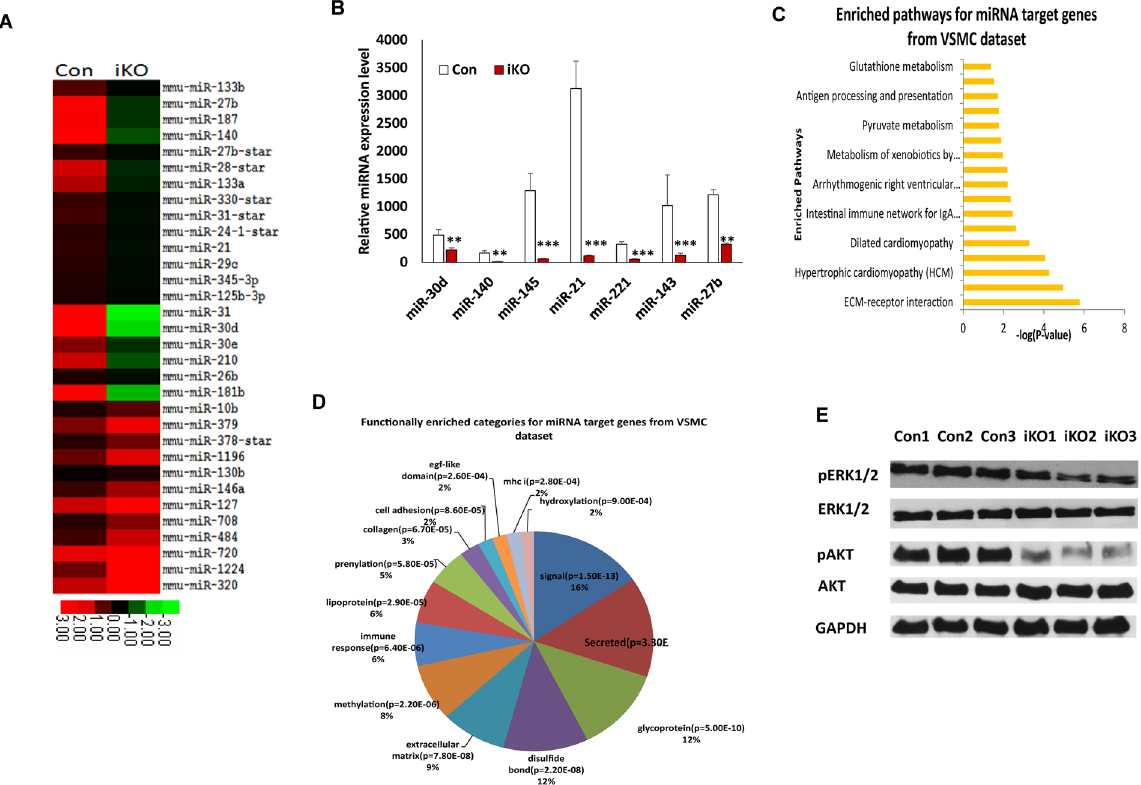
Figure 5. miRNA and multiple signaling pathway were dysregulated in DGCR8iKO mice. ( A ) Heat map of miRNA expression in DGCR8iKO and control mice. ( B ) miRNA expression was verified by polyA tailing real- time RT-PCR. All of them were downregulated at least several-fold in DGCR8iKO compared to control mice ( ** p < 0.01; *** p < 0.001). ( C ) miRNA-targeted multiple gene pathways were altered in DGCR8iKO mice as analyzed using DAVID bioinformatics. ( D ) miRNA-targeted genes were functionally enriched. ( E ) Two cellular survival pathways in the primary VSMCs of DGCR8iKO were examined by Western blot (full blot shown in Fig. S2A and